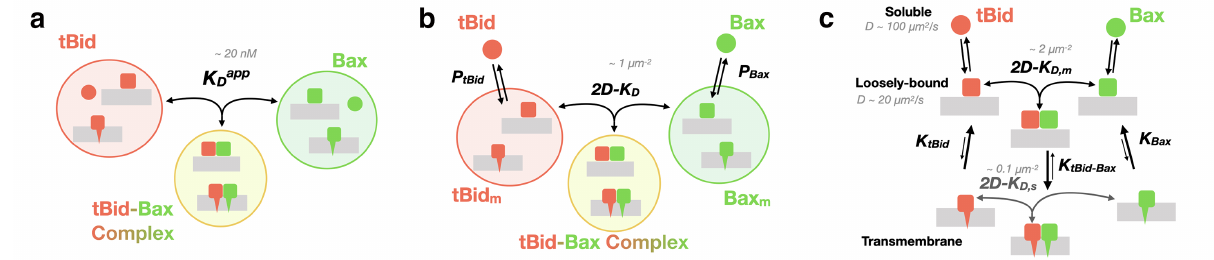
Figure 8. Three different levels of models for the tBid-Bax interaction. ( a ) In the simplest model, all the forms of tBid, Bax and the tBid-Bax complex are each considered as a separate conformational ensemble. The interaction between the tBid and Bax ensembles is described by a simple apparent dissociation constant, K app . ( b ) An improved version of the simple D model in (a) considers the solution and membrane forms of each protein as separate conformational ensembles (the tBid-Bax complexes exist only as membrane-associated complexes). At equilibrium the system is described with two partition coefficients, P tBid , P Bax , characterizing the equilibrium (retro-translocation) between the solution and membrane forms of each protein, and a two-dimensional dissociation constant, 2 D − K D . ( c ) A more accurate model, where the membrane forms of each protein are separated into two different conformational ensembles based on their degree of insertion in the membrane (but regardless of stoichiometry), is necessary to explain the results of our single particle experiments. The equilibrium of this system is described by four independent partition coefficients, and two two-dimensional dissociation constants, 2 D − K D , m for the mobile loosely-bound proteins and 2 D − K D , s for the stationary deeply inserted